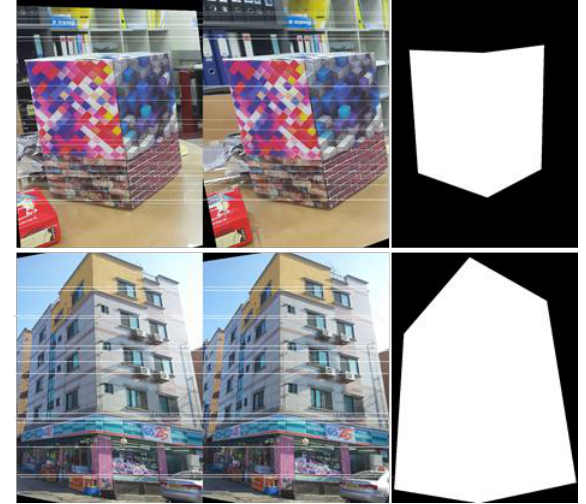
Figure 6. Epipolar resampled stereo images and ROI